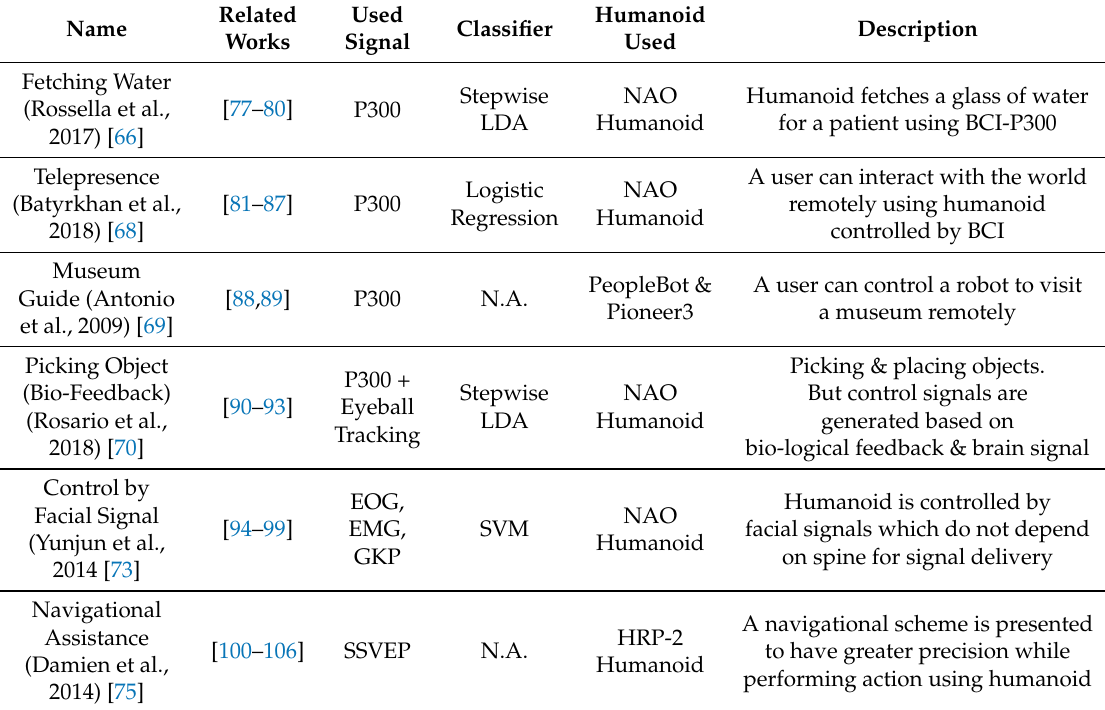
Table 7. Summary of